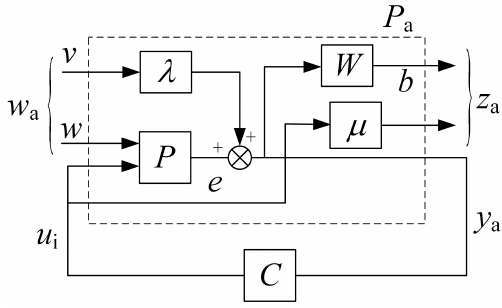
Figure 5. Block diagram of the standard H ∞ problem.